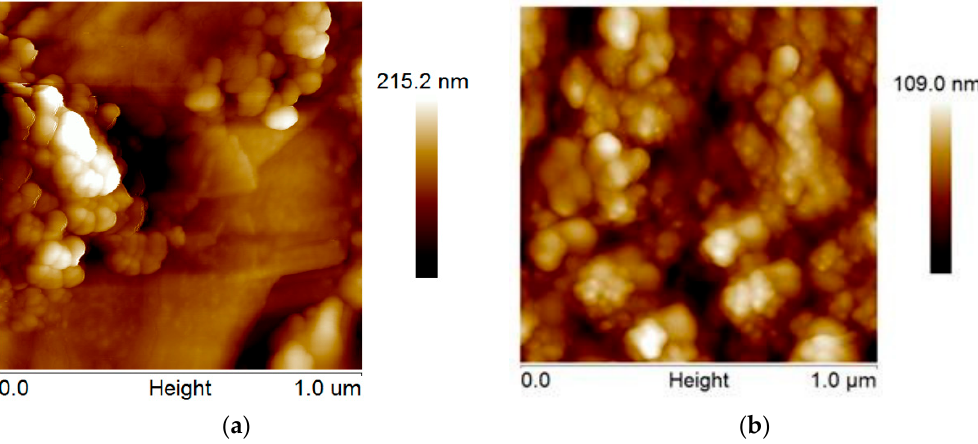
Figure 10. ( a ) AFM image of PdNPs/SPC TTF E prepared under method B andCV1conditions; and ( b ) AFM image of PdNPs/SPC TTF E prepared under method B and CV2